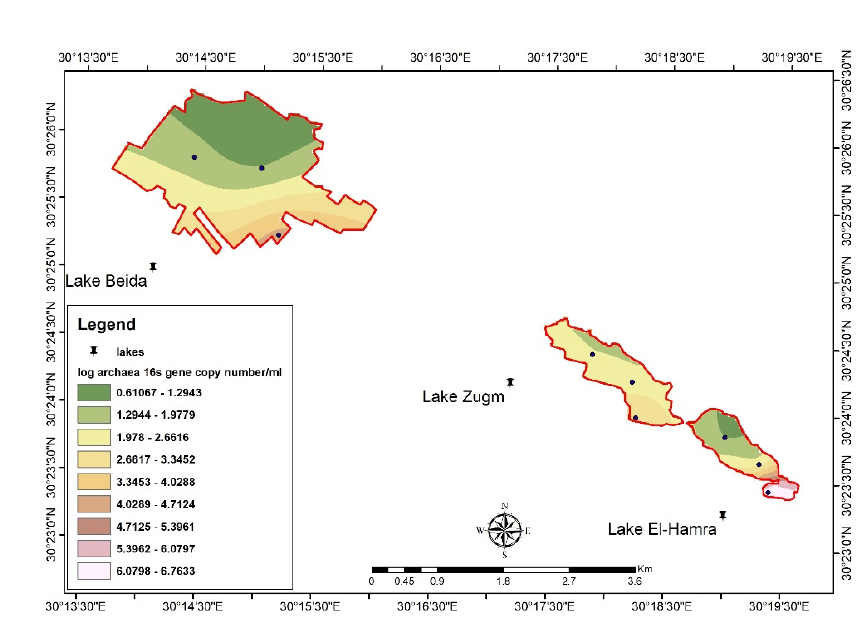
Figure 9. DNA copy number distribution of the archaeal 16S rRNA gene ( A ) per gram of sediment and ( B ) per mL of water from soda lakes of Wadi El-Natrun.